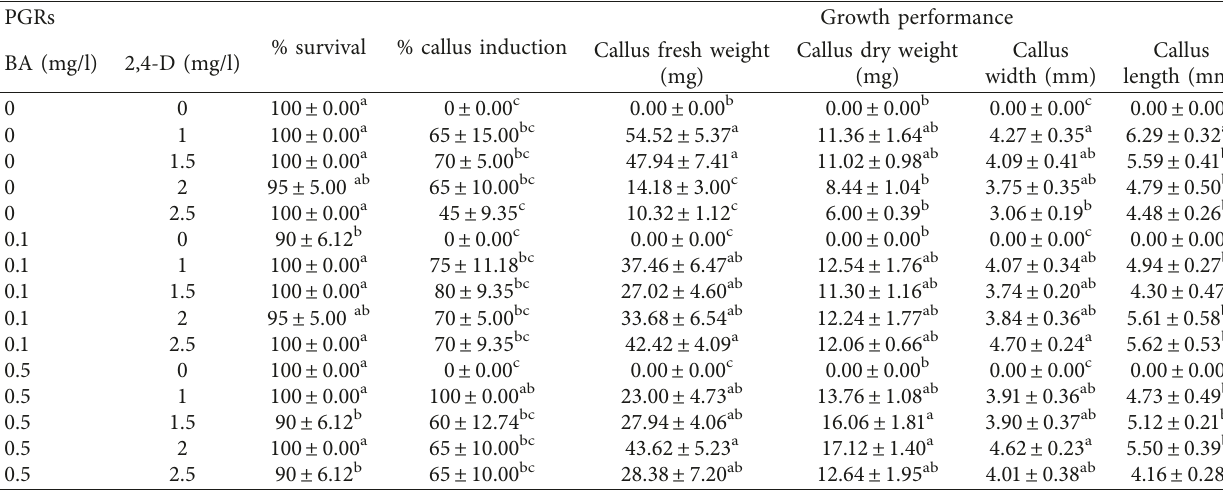
Table 1: Induction performance and characteristics of calli derived from Luem Pua rice seeds after culture on MS medium supplemented with various concentrations of 2,4-D (dichlorophenoxyacetic acid) and BA (benzylaminopurine) for three weeks. PGRs